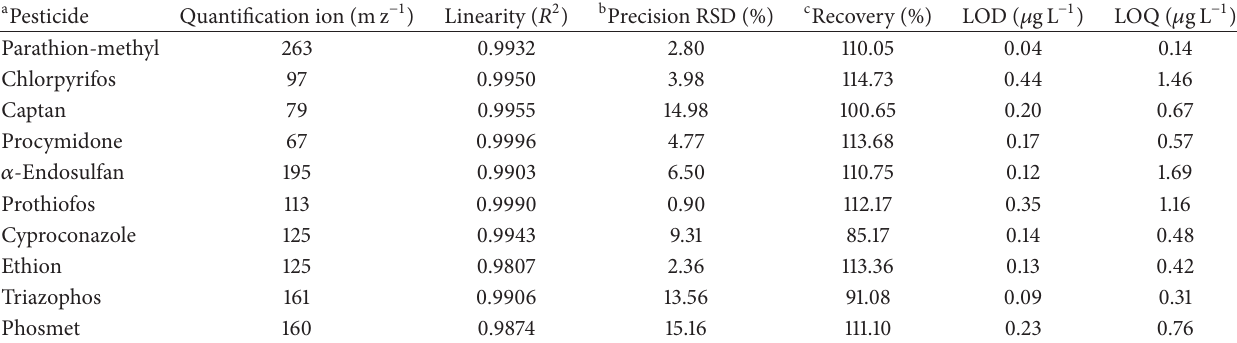
Table 2: Analytical performance of GC/MS method using HF-LPME for the extraction of pesticides in environmental water.